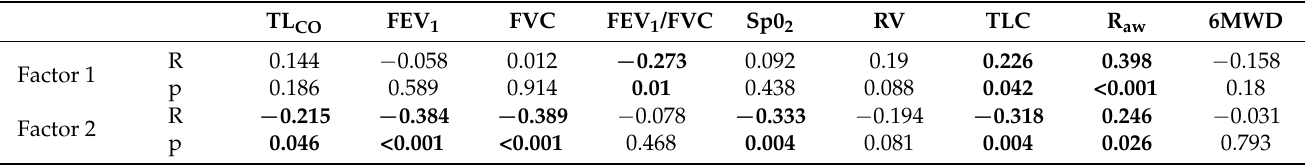
Figure 3). R, Spearman’s rank correlation coefficient; TL CO , lung transfer capacity for carbon monoxide; FEV 1 , forced expiratory volume during the first second; FVC, forced vital capacity; SpO 2 , oxygen saturation;